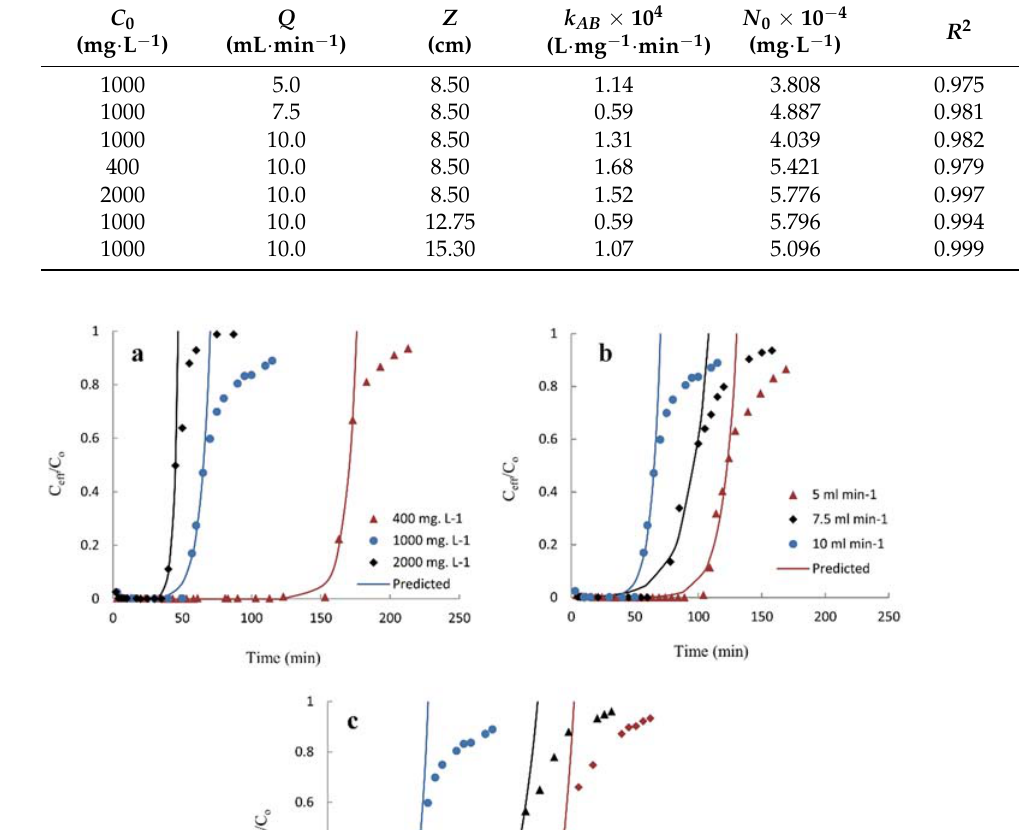
Table 4. The Adams–Bohart model’s parameters under various circumstances.